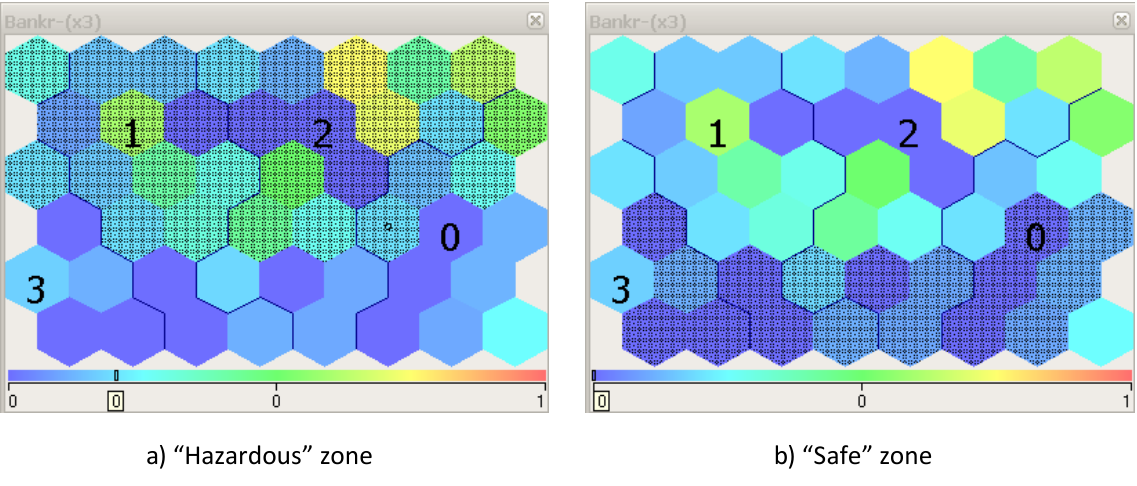
mapa) “Hazardous” zone b) “Safe” Figure 3. SOM (2014–2017). Global zones on the bank solvency